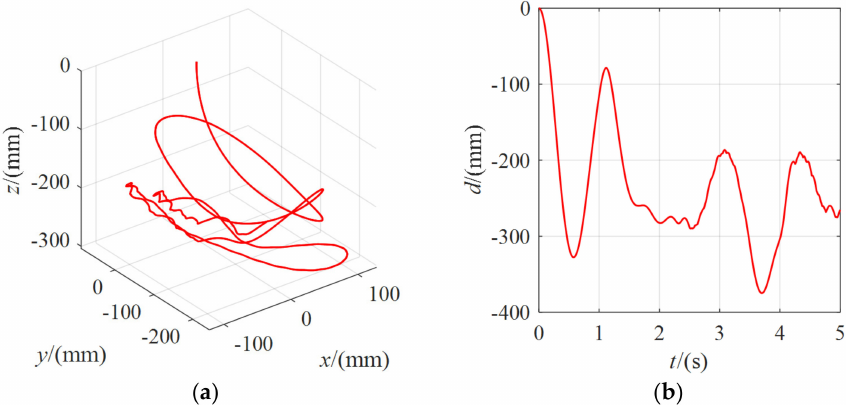
Figure 14. The position change of the moving platform under the external force of 10 N for λ = 80: ( a ) the coordinate curve of the moving platform center point in the spatial coordinate system O-xyz ; ( b ) the variation curve of the linear distance between the center point of the moving platform and the initial